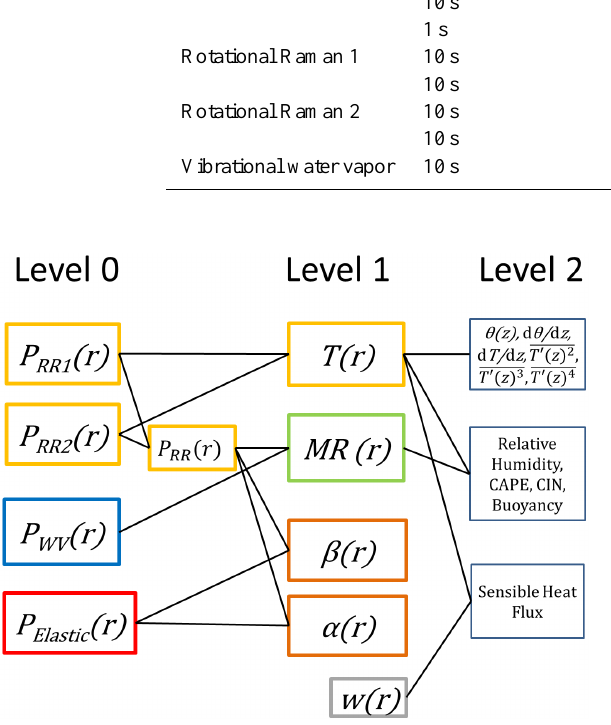
Figure 4. Diagram of the data products. Level 0 data are the background-corrected rotational Raman signals (yellow), the vibra- tional Raman signal of water vapor (blue), and the elastic backscat- ter signal (red). A temperature-independent reference signal P RR is obtained from the temperature-dependent rotational Raman signals. Level 1 data products are temperature T , water vapor mixing ratio MR, particle backscatter coefficient β , and particle extinction coef- ficient α . Higher-level products derived from level 1 data: potential temperature θ , gradient of temperature and potential temperature, higher moments of turbulent temperature fluctuations T (cid:48) , relative humidity, buoyancy, CAPE, and CIN. For deriving the sensible heat flux, profiles of the vertical wind w , e.g., from a Doppler lidar, are